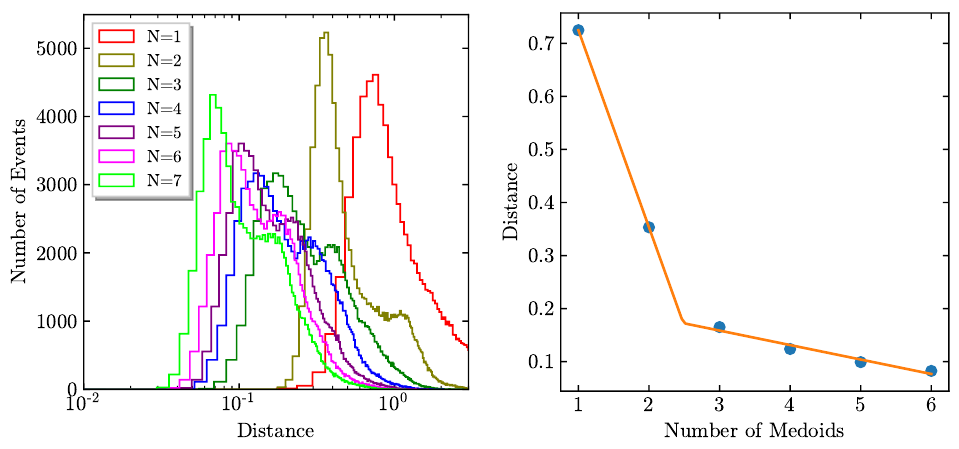
Figure 7 . Example of the elbow method. Left shows histograms of the 1-Wasserstein distance to the closest medoid, with colors corresponding to the number of medoids. Right plots the peak of each of these histograms, as a function of the number of